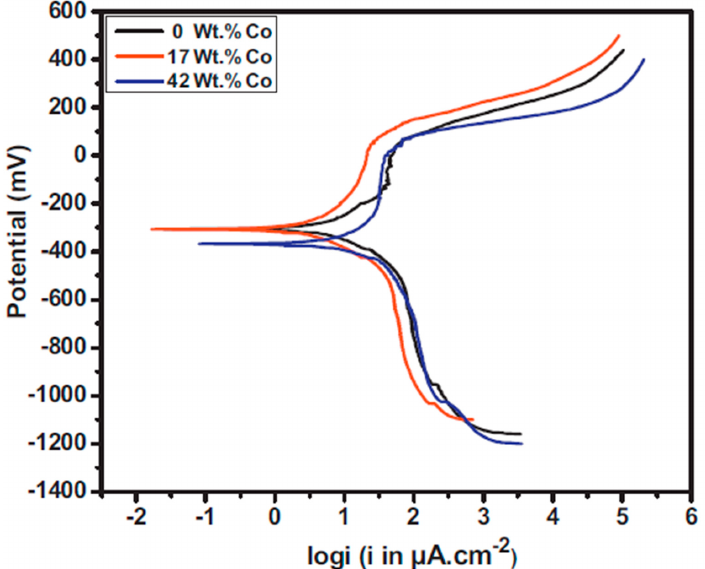
Figure 13. The potentiodynamic polarization curves of the Ni–Co alloy coating as a function of the cobalt content [126]. Reprinted from Applied Surface Science, 307, Babak Bakhit, Alireza Akbari, Farzad Nasirpouri, Mir Ghasem Hosseini, Corrosion resistance of Ni–Co alloy and Ni–Co/SiC nanocomposite coatings electrodeposited by sediment codeposition technique/Pages No. 351–359, Copyright (2020), with permission from Elsevier.